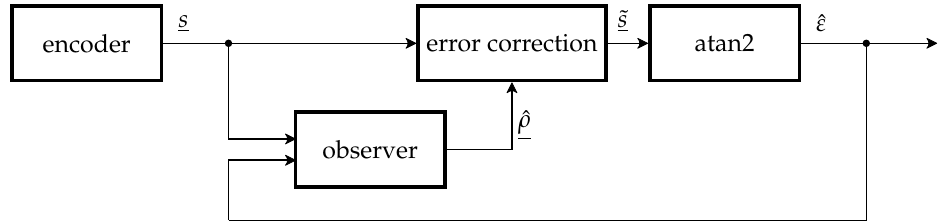
Figure 2. Scheme of the proposed Harmonic Error